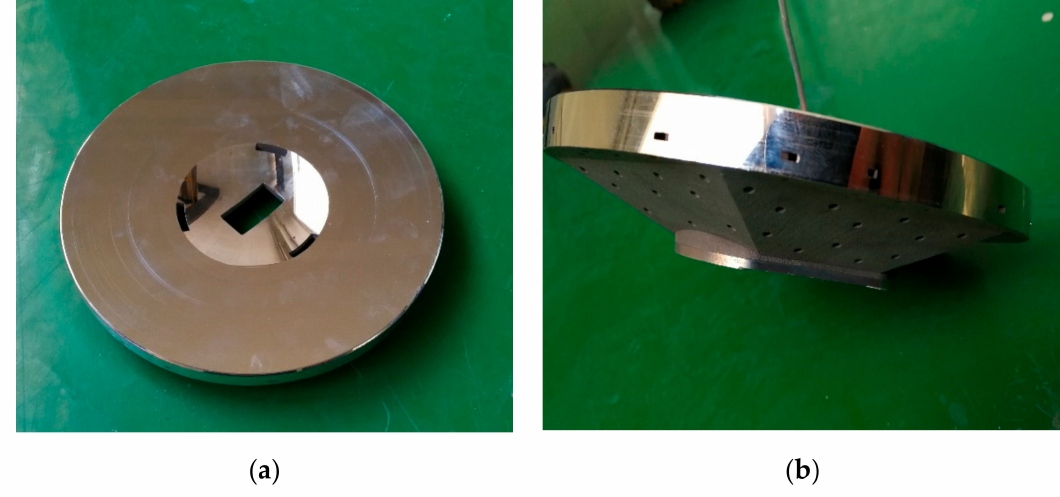
Figure 12. The mirror after surface modification: ( a ) front view; ( b ) side